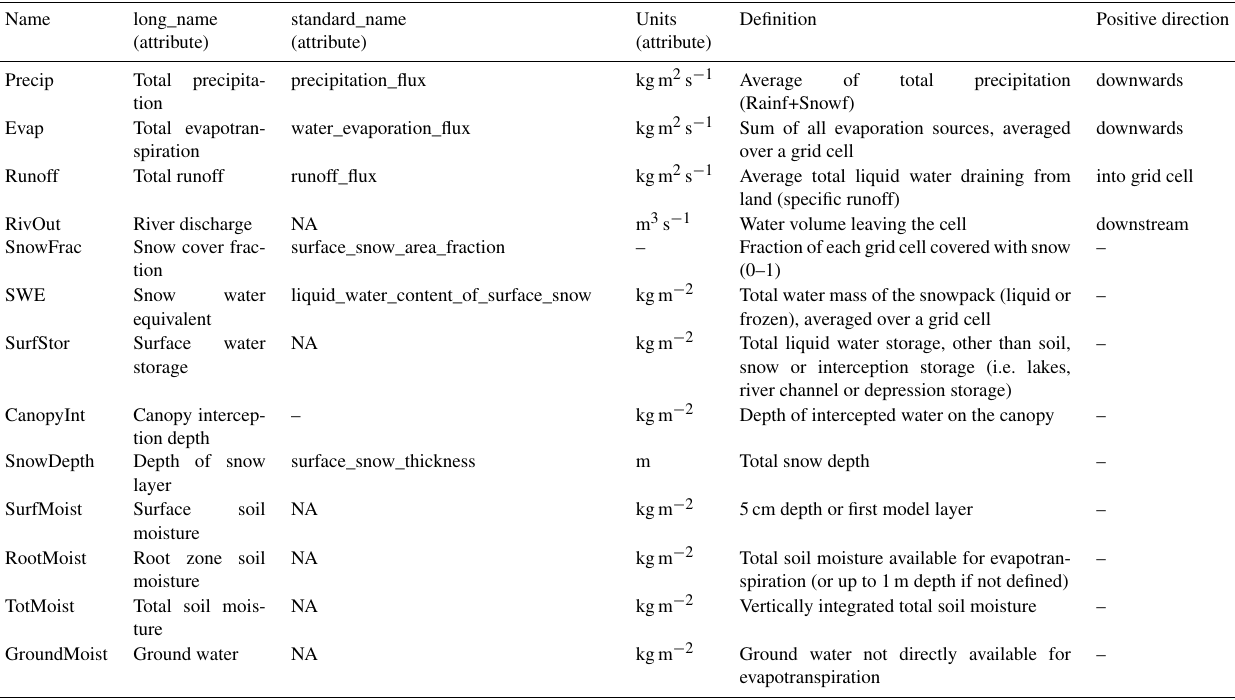
Table 3. List of most important output variables and conventions. If a standard name is not available the name will be used in the respective netCDF